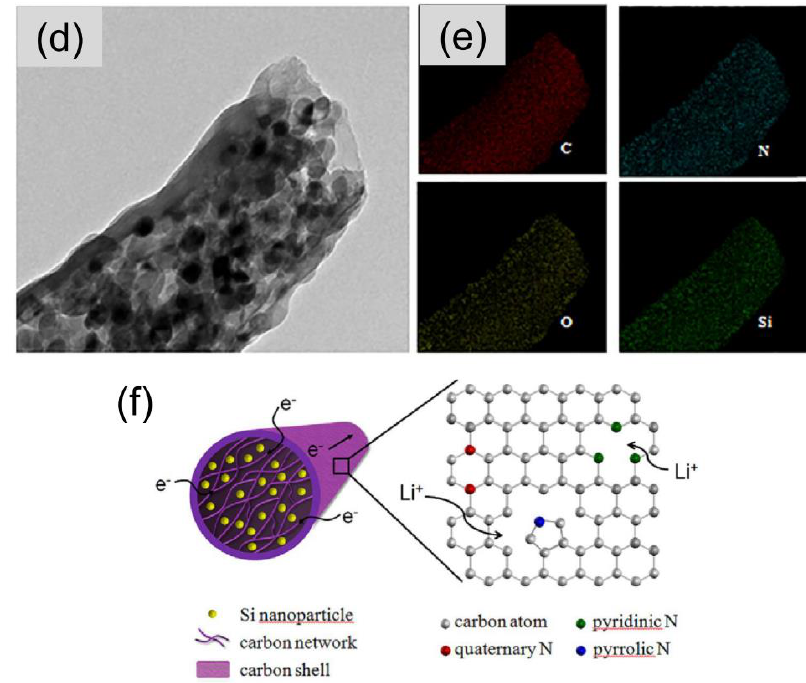
Figure 8. ( a ) Schematic illustration of the Si/C@CNF fabrication process. ( b , c ) SEM and ( d ) TEM images of Si/C@CNF and ( e ) elemental mapping of the fiber components. ( f ) Sketch of Li + and e − conduction paths in the Si/C@CNF electrode (reproduced from reference [82] with permission. Copyright 2018, Elsevier).